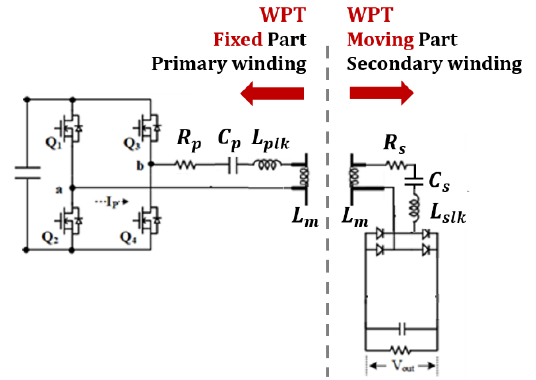
Figure 4. The topology of the wireless power transfer.